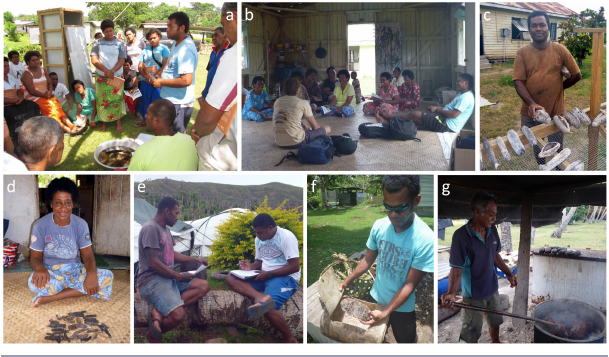
Fig. 2 . Photos depicting capacity building, data collection, and fishers with processed sea cucumbers in Fiji: (a) a training workshop at Taveuni, (b) a focus-group discussion session with women at Vanua Balavu, (c) a fisher in the southern Lau Group with dried sea cucumbers, (d) a woman fisher at Kadavu with processed sea cucumbers, (e) a questionnaire-based interview of a fisher at Vanua Balavu, (f) a fisher with a black teatfish ( Holothuria whitmaei ) being salt cured, (g) fisher cooking sea cucumbers in village on Vanua Balavu. Photos a, g: